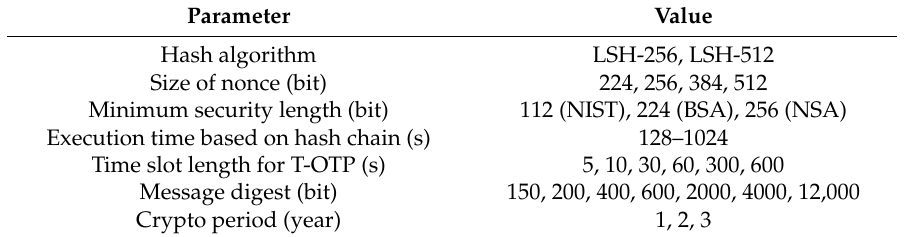
Table 7. Configuration of parameters in LSH-based multi-factor hash chain with T-OTP scheme.